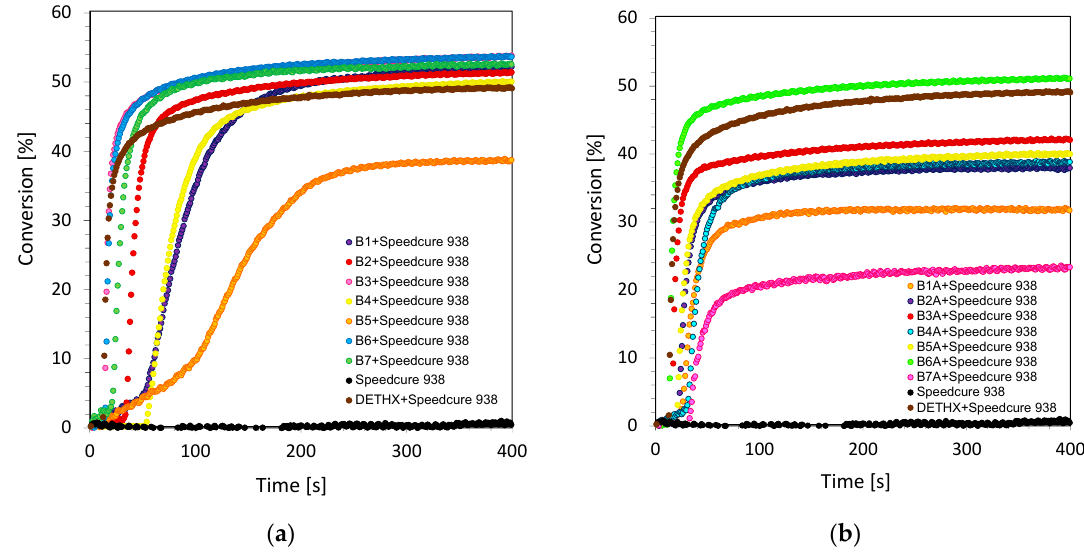
Figure 5. Free-radical photopolymerization profiles (acrylate function conversion vs. irradiation time) for TMPTA with the bimolecular photoinitiating system based on ( a ) series 1 of 2-amino-4-methyl-6-(4-phenylphenyl)benzene-1,3-dicarbonitrile derivatives and Speedcure 938 (0.1% / 1% w / w) under visible light LED source 365 nm; ( b ) series 1 of 2-amino-4-methyl-6-(4-phenylphenyl)benzene-1,3-dicarbonitrile derivatives and Speedcure 938 (0.1% / 1% w / w) under visible light LED source 365 nm.